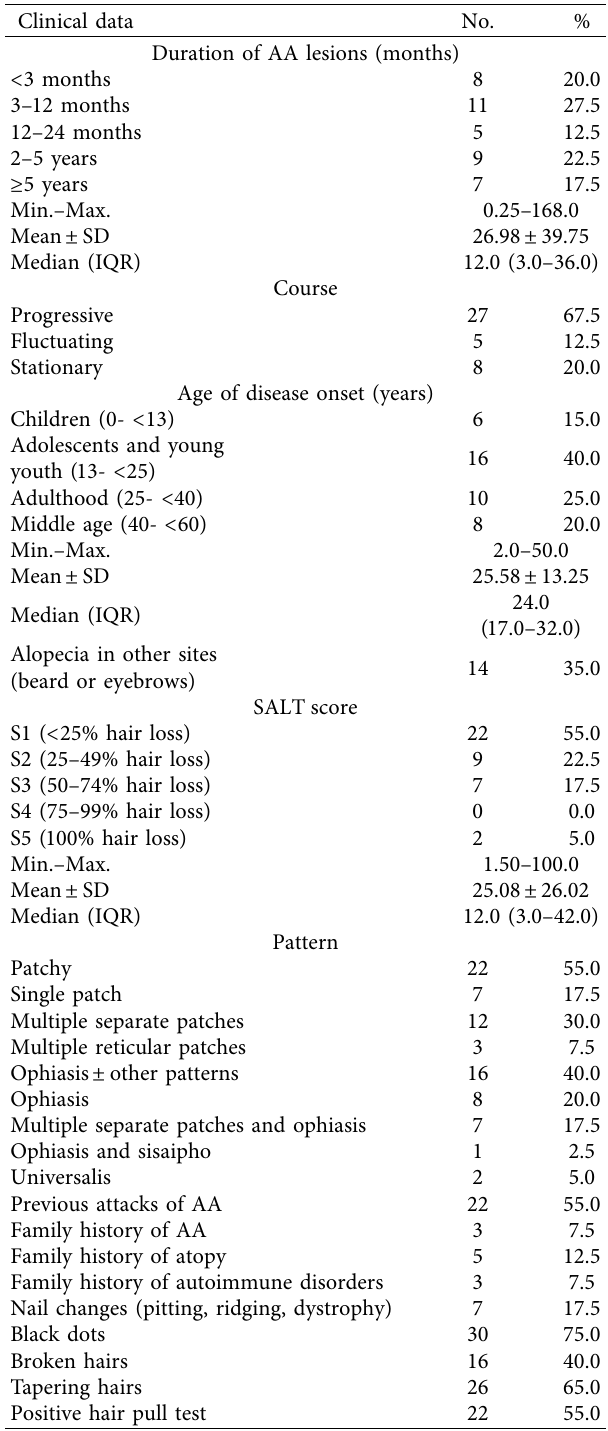
Table 2: Clinical data of patients with AA ( n �